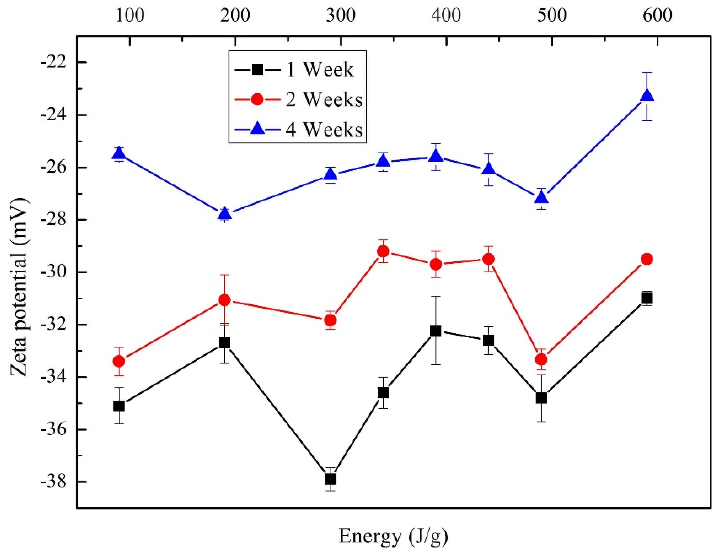
/ TX-100 / H 2 O changing the dispersion